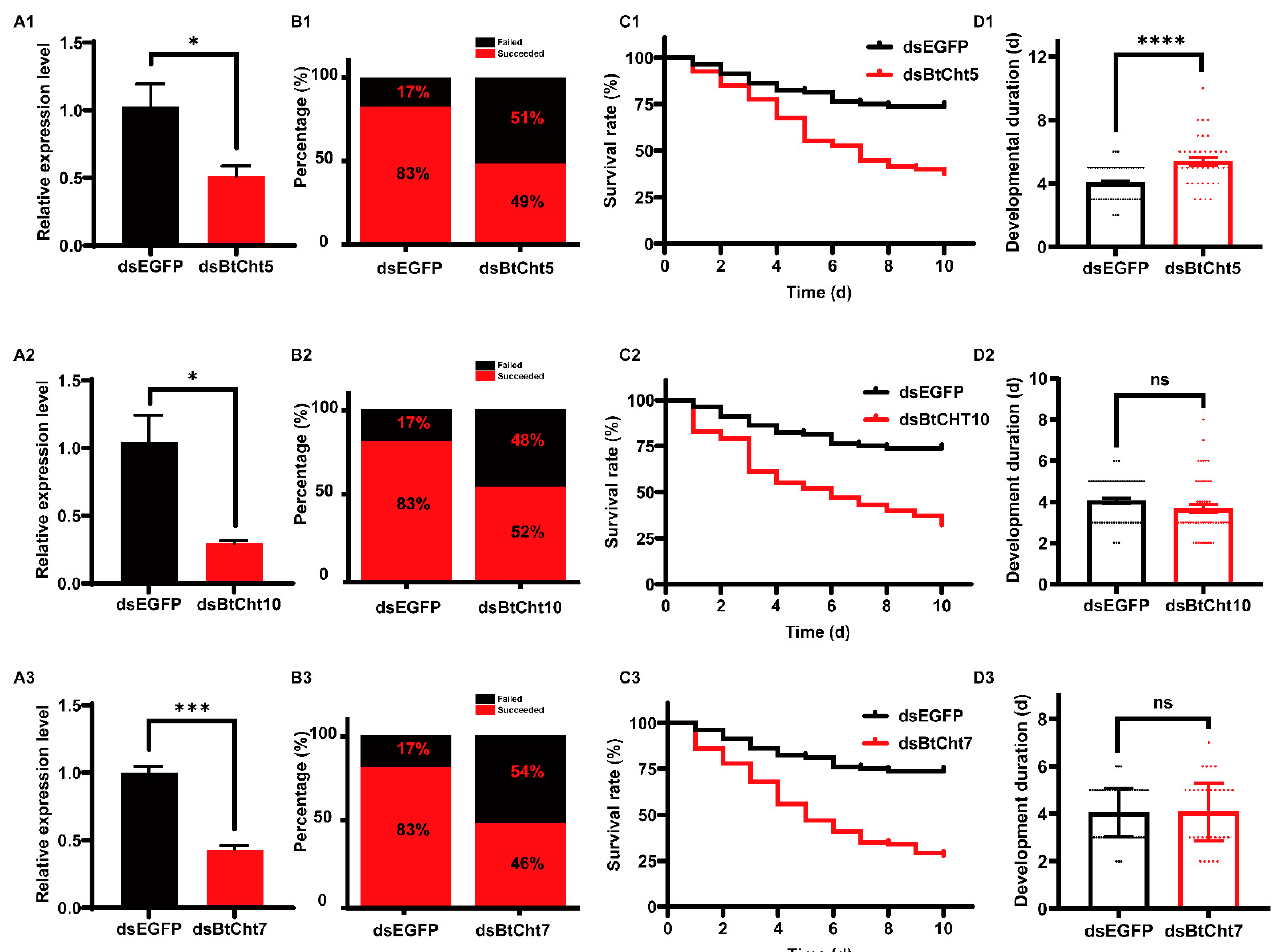
Figure 6. RNAi effects of three B. tabaci chitinases ( BtCht10 , BtCht5 and BtCht7 ) on survival and developmental duration from second instar nymph to third instar nymph. ( A ) Efficiency of RNA interference on target genes. Nymphs were collected after two days of treatment with dsRNA and expression levels of target genes were quantified by qRT-PCR. Error bars indicate standard error of mean ( n = 3). ( B ) Percentage of nymphs that succeeded (indicated by red) or failed (indicated by black) to survive a molt course after dsRNA (0.5 μ g/ μ L) treatment. ( C ) Survival curves of B. tabaci after exposure to dsRNA (0.5 μ g/ μ L). For each treatment about 80~100 s instar nymphs were continuously recorded for 10 days and data were used to make the survival curves. ( D ) Developmental duration (from second instar to third instar) of nymphs treated with dsRNA (0.5 μ g/ μ L). All second instar nymphs that successfully experienced a molt were used to analyze the developmental duration. * p < 0.05, *** p < 0.001, **** p < 0.0001.